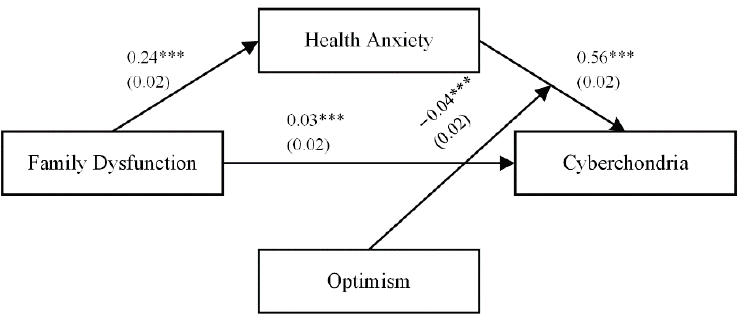
Figure 2. The final moderated mediation model. Note. Standardized coefficients are reported with standard errors in parentheses. Participants’ grades, family structure, SES, and BMI, as well as OHR, were controlled. *** p < 0.001.